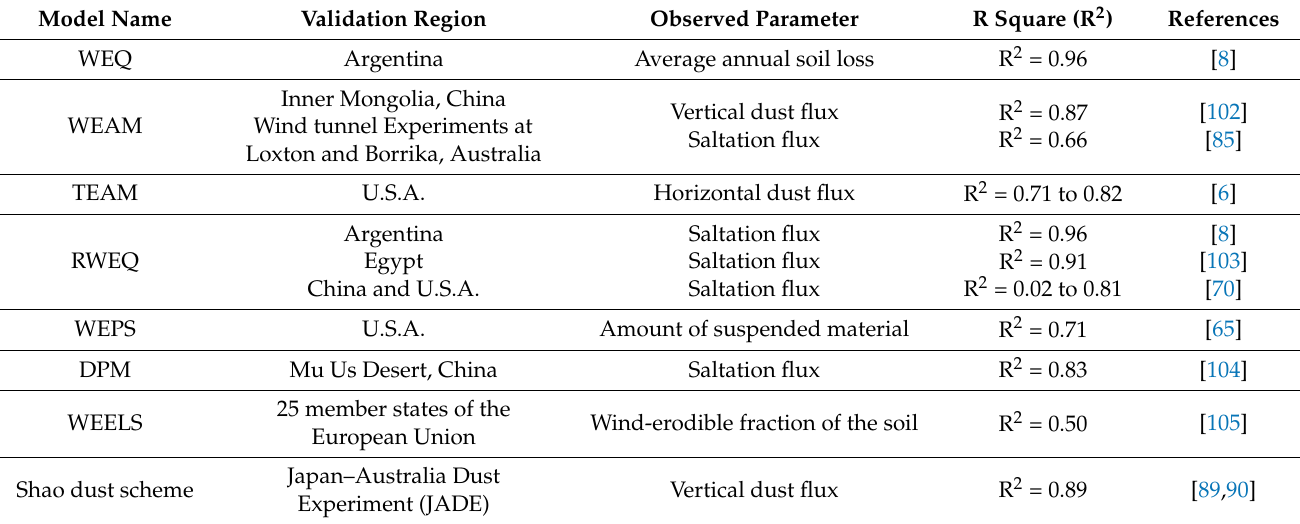
Table 2. Performance of selected dust